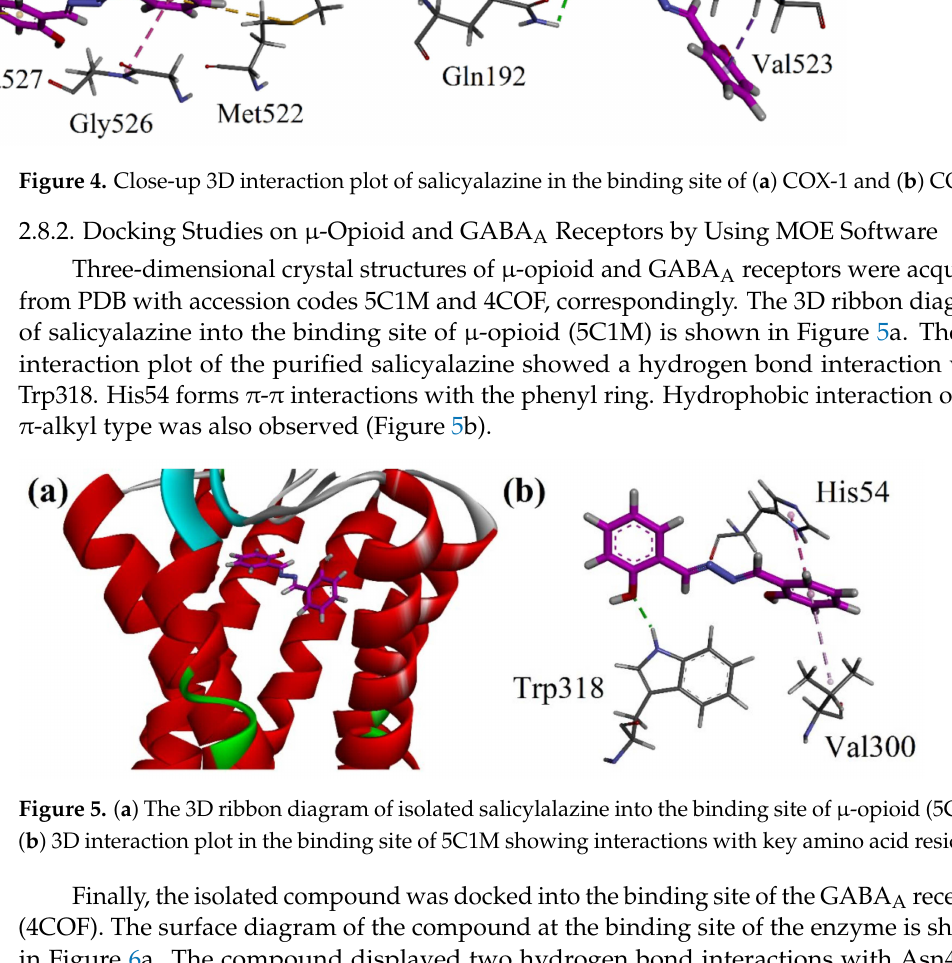
(4COF). The surface diagram of the compound at the binding site of the enzyme is shown